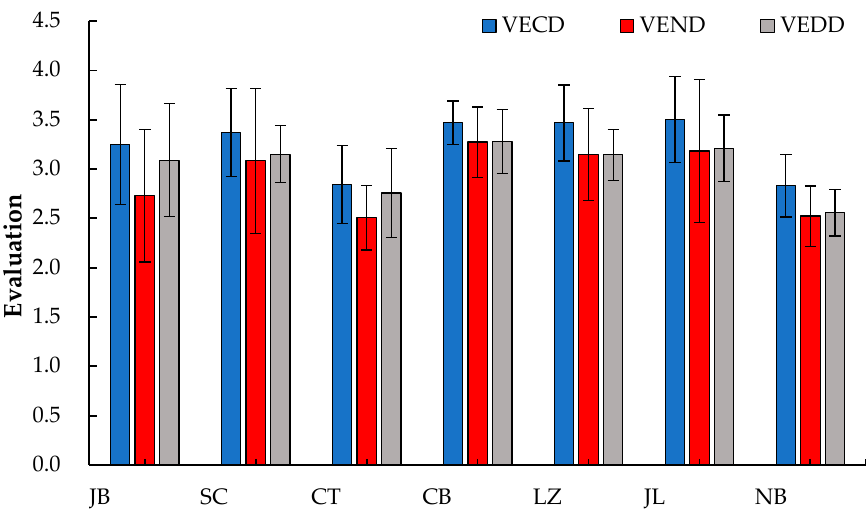
Figure 6. Results of VECD, VEND, and VEDD in seven WSMCs. VECD = visual environment comfort degree; VEND = visual environment natural degree; VEDD = visual environment diversity degree. Table 7. Average proportions of five categories of odors in seven WSMCs.